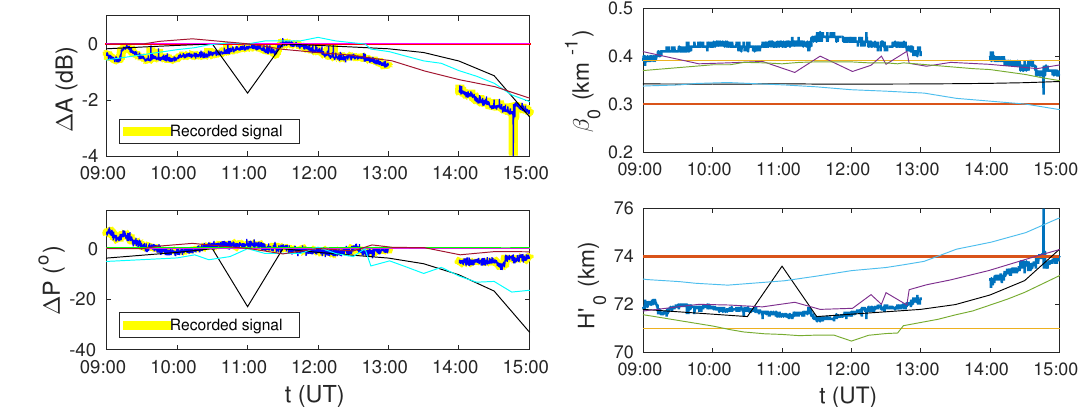
Figure 11. Daytime variations of the amplitude and phase changes ( left panels ) and Wait’s parameters ( right panels ) during 6 September 2014 obtained by Quiet Ionospheric D-Region (QIonDR), default Long-Wave Propagation Capability (LWPC), and International Reference Ionosphere (IRI) models and compared with data presented in studies indicated in legend [22,27,33,35,52,53]. The gap between 13 UT and 14 UT is due to the one hour break in data receiving by the Atmospheric Weather Electromagnetic System for Observation Modeling and Education (AWESOME) receiver.